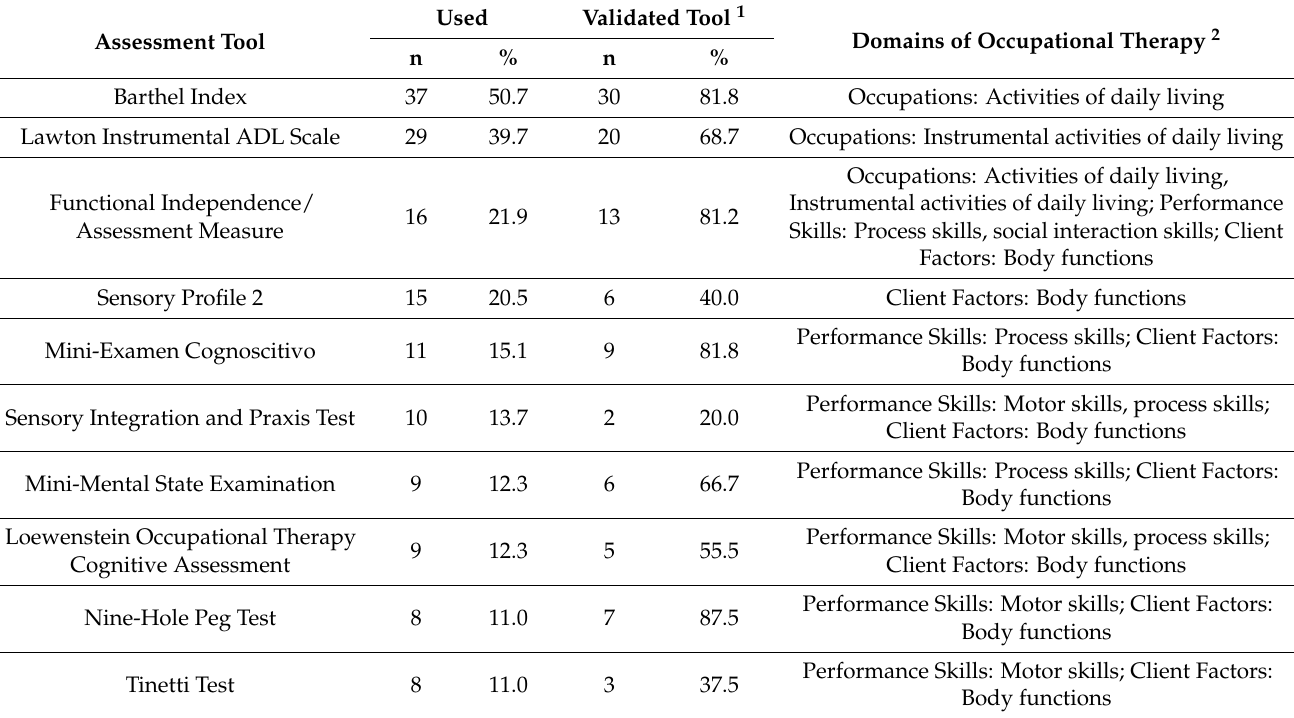
Table 3. Ranking of the ten assessment tools most frequently used by the study